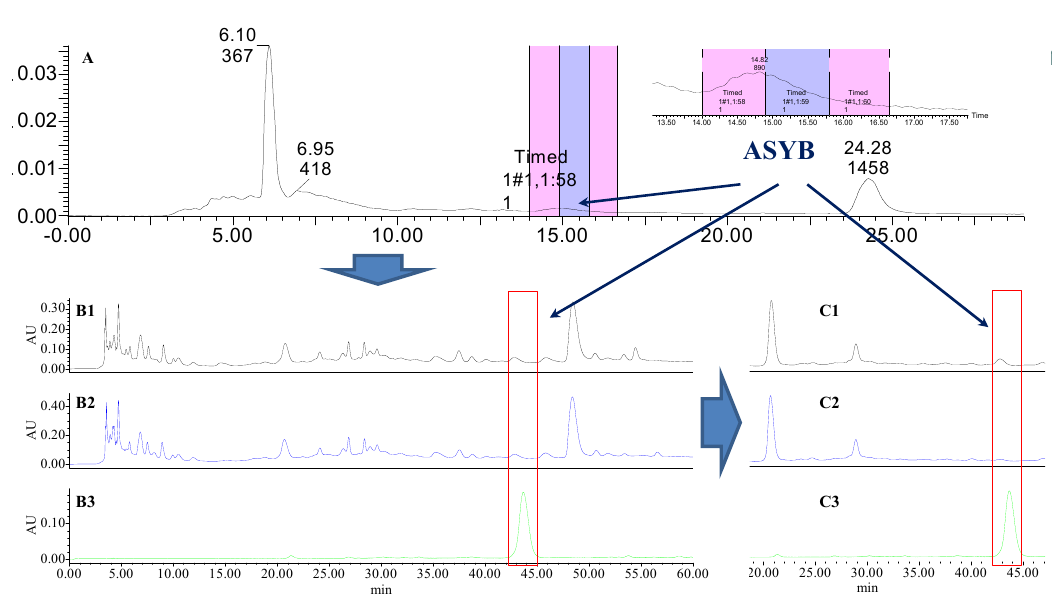
Figure 13. The preparative and analytical chromatograms of the depletion of ASYB from CF-SM.